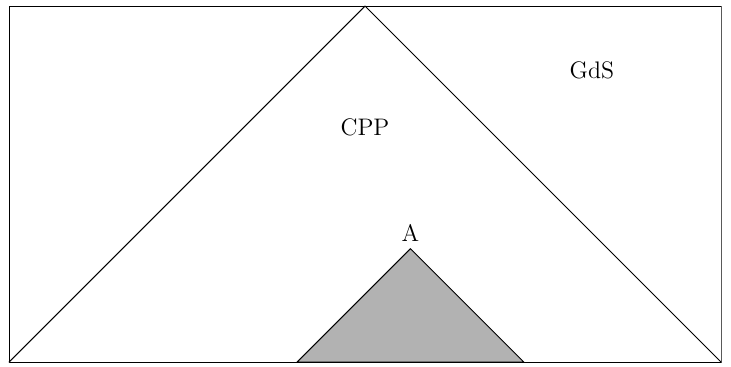
Figure 3 . The Penrose Diagram for the two-dimensional de Sitter space-time. The shaded region corresponds to the causal connected points with the given point A . It is easy to see that the whole shaded region lies in a Contracted Poincare